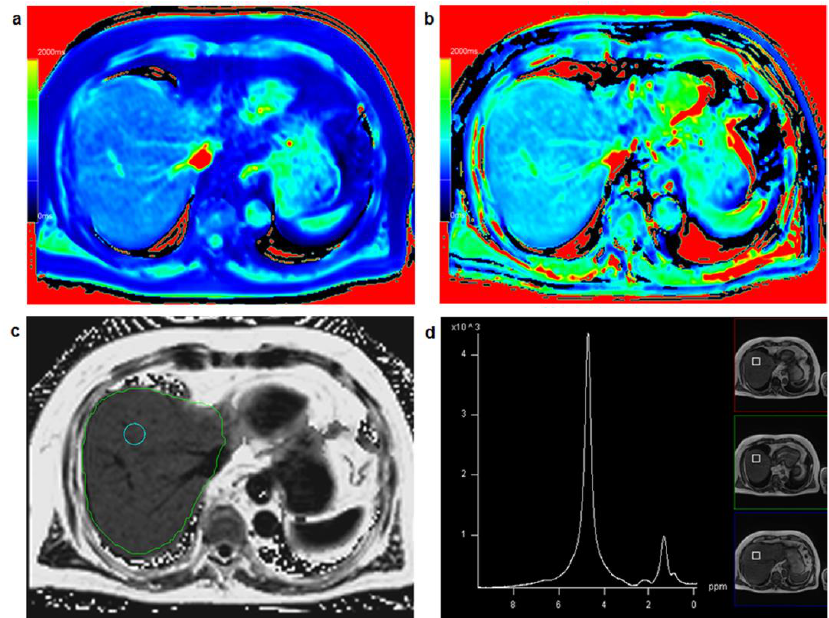
Figure 3. A 75-year-old male patient: T1 mapping from in-phase signal ( a ) and water-only signal ( b ) yielded clearly different T1 relaxation times for T1_in (= 733 ms) and T1_W (= 880 ms) suggesting increased fat fraction in the liver with a fat fraction calculated from T1 mapping FF_T1 = 20.1%. Comparing T1_in and T1_W maps with identical window and center setting yields clearly different color impression of the liver. PDFF mapping ( c ) resulted in PDFF = 17.6%, PDFF_MRS in a co-localized voxel ( d ) was 19.6%. PDFF, PDFF_MRS and FF_T1 showed a very high correlation coefficient (Table 2), all correlations were significant at the p < 0.001 level.